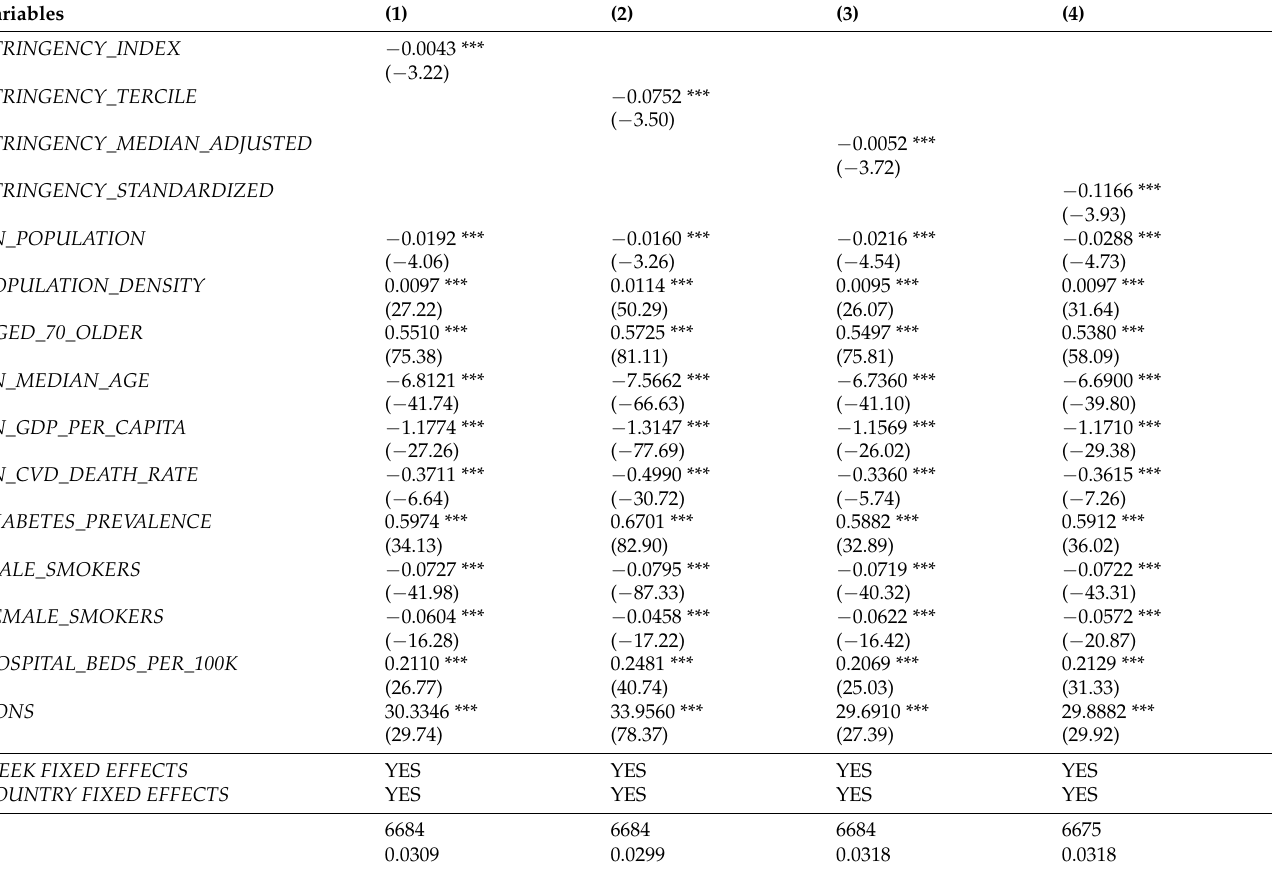
Table 2. Regression analysis of the effect of government policy stringency index on the COVID-19